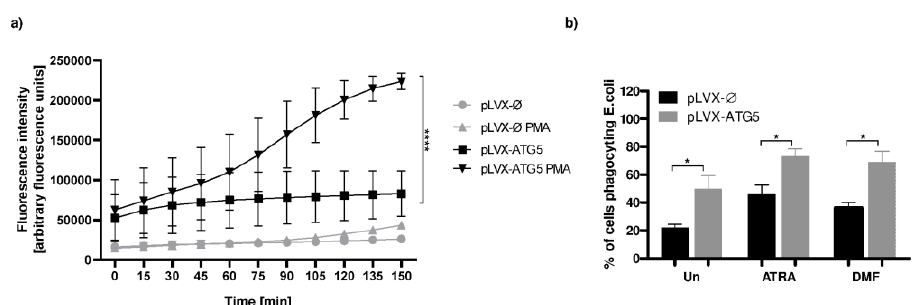
Figure 4. Increased expression of ATG5 leads to augmented reactive oxygen species (ROS) production and increased phagocytosis level in dHL-60-ATG5 cells. ( a ) The mock control HL-60 and HL-60-ATG5 cells after differentiation with 1 µM ATRA were loaded with dihydrorhodamine (DHR) 123 and left unstimulated or stimulated to release NETs with 100 nM PMA. Fluorescence was monitored every 15 min for 150 min post stimulation. ( b ) Mock control HL-60 and HL-60-ATG5 cells differentiated with 1 µM ATRA or 70 mM DMF were incubated with fluorescently labeled 25 µg E. coli bioparticles and after a 30-min incubation the percentage of phagocyting cells was measured with a flow cytometer ( a , b ) The means + SEM from 5 independent experiments or ( b ) 7 independent experiments are shown, ( a ) two-way ANOVA with Dunnett’s correction for multiple comparisons or ( b ) one-way ANOVA with post-hoc Newman-Keuls test. * p ≤ 0.05, **** p ≤ 0.0001